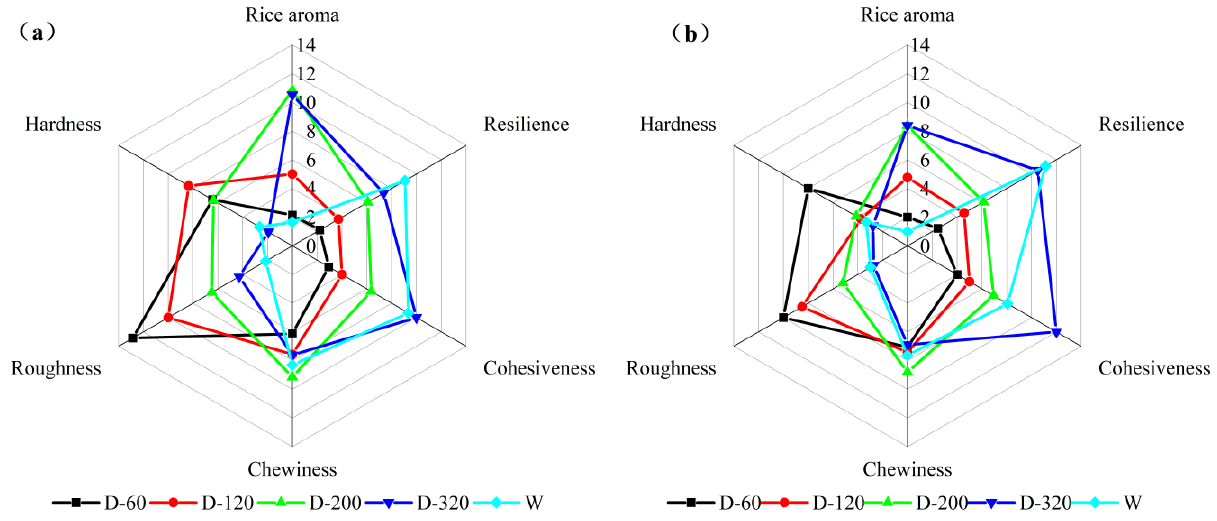
Figure 7. Differences in sensory evaluation of waxy rice balls. ( a ) stands for IWR and ( b ) stands for JWR. for